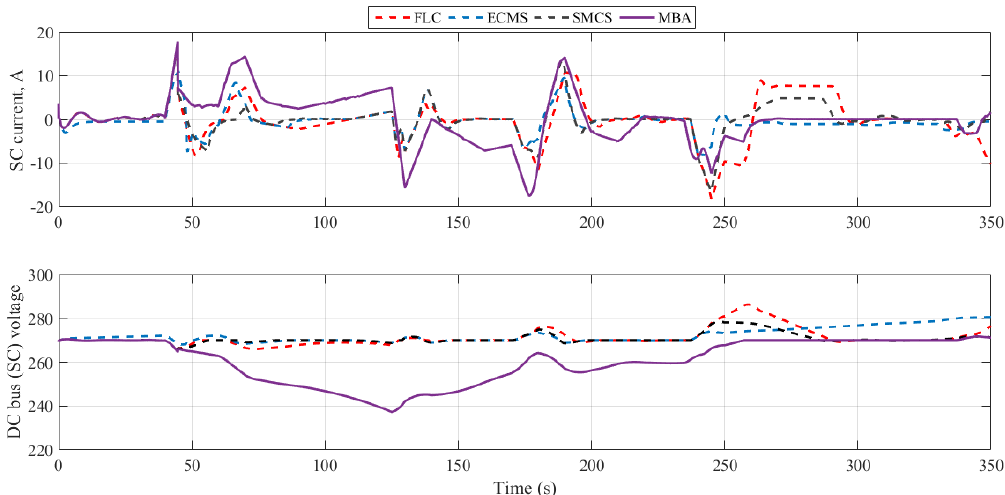
Figure 14. Time responses of the battery’s SOC, current , and voltage.